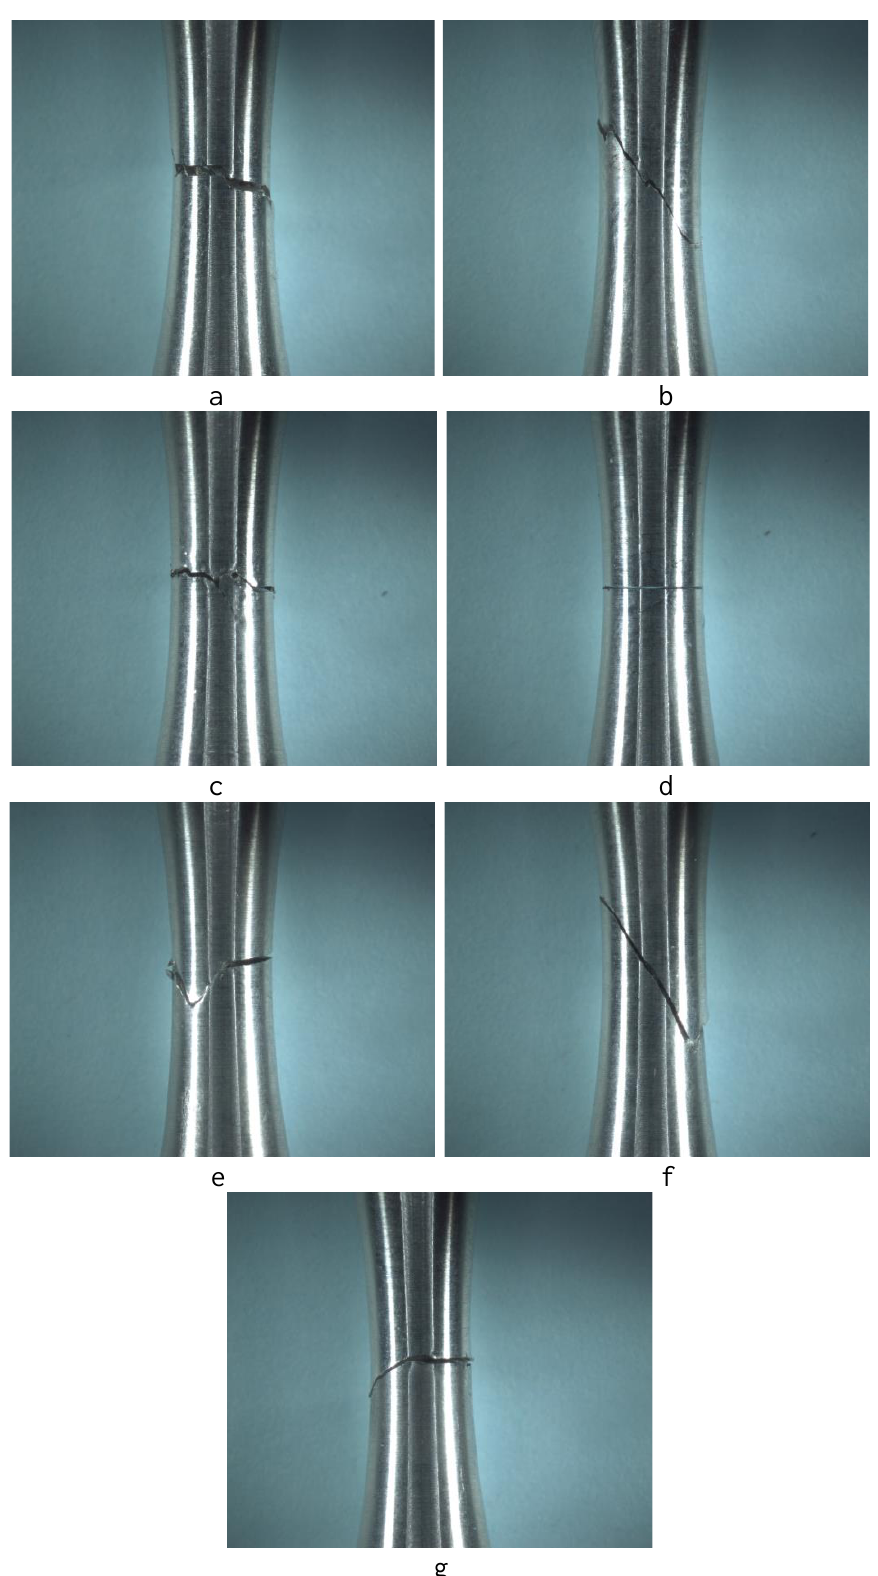
Figure 2: Specimens after fatigue